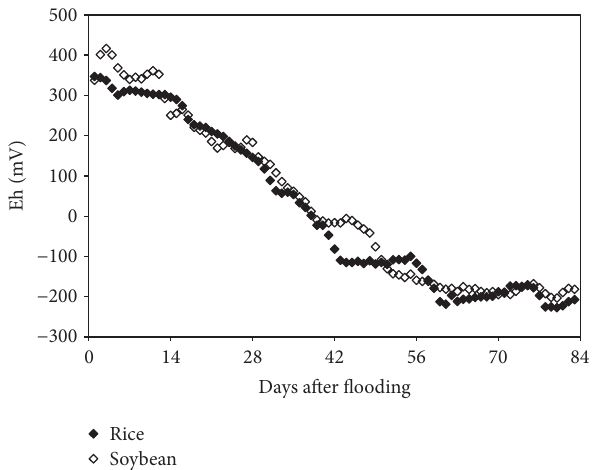
Figure3:Soiloxidation-reductionpotential(Eh)atthe7.5 cmdepth over the flooded portion of the 2013 growing season for CLXL745 and Cheniere at the Northeast Research and Extension Center in Keiser, Arkansas.